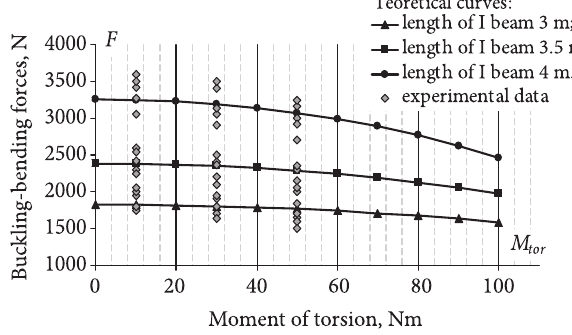
fig. 4. Dependence of critical buckling-bending forces and moment of